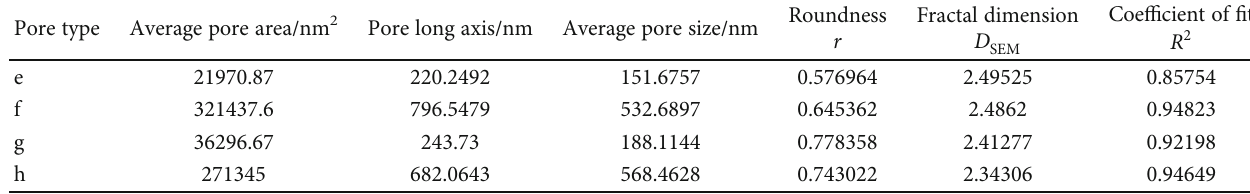
Table 3: Pore parameters and fractal dimension extracted from SEM images of Well Y1.